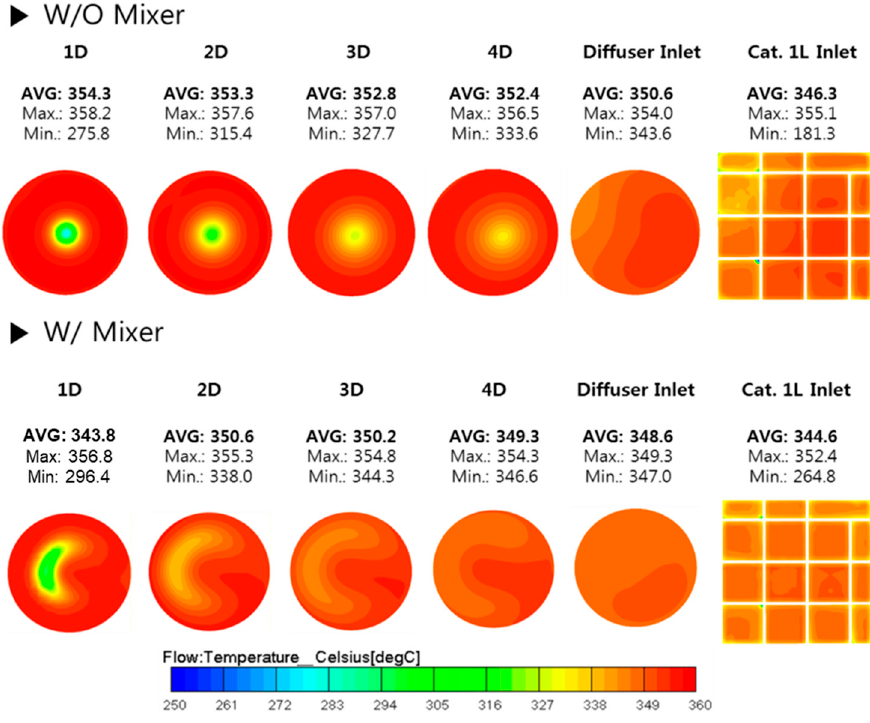
Figure 5. Mean temperature distribution at specific locations with and without mixer.